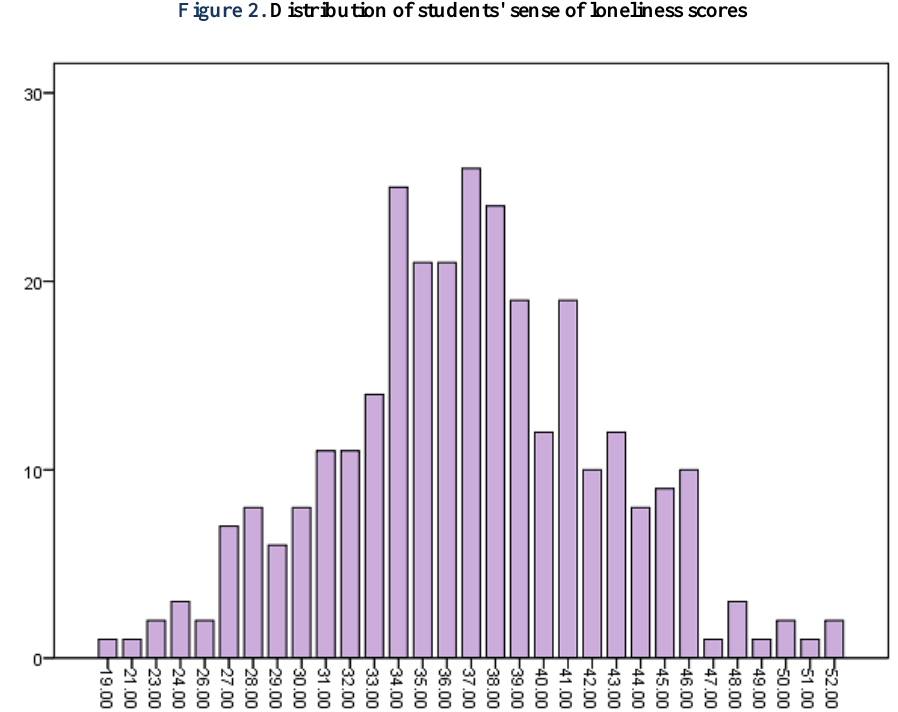
Figure 3. Distribution of students' informational identity